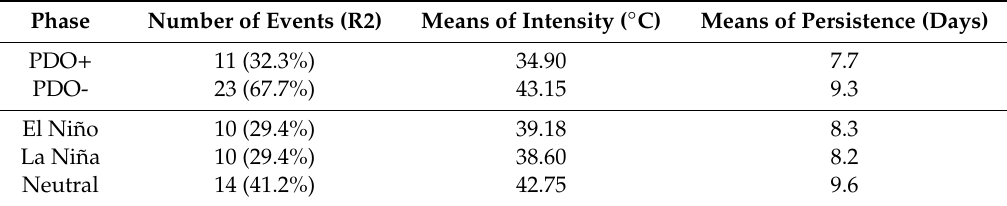
Table 4. Number of heat waves in region 2 (R2), the corresponding means of intensity ( ◦ C) and persistence (days) of the events in each phase of the ENSO and